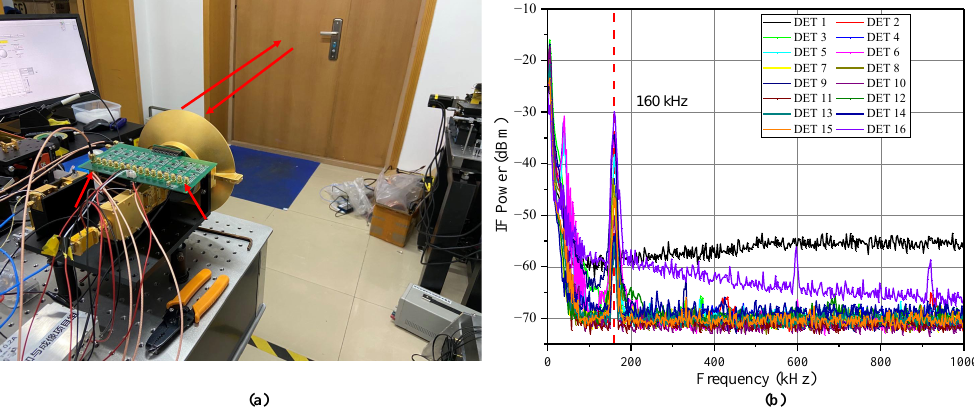
Figure 20. ( a ) The setup of the ranging experiment using the proposed receiver front-end. ( b ) The IF spectrum of the ranging